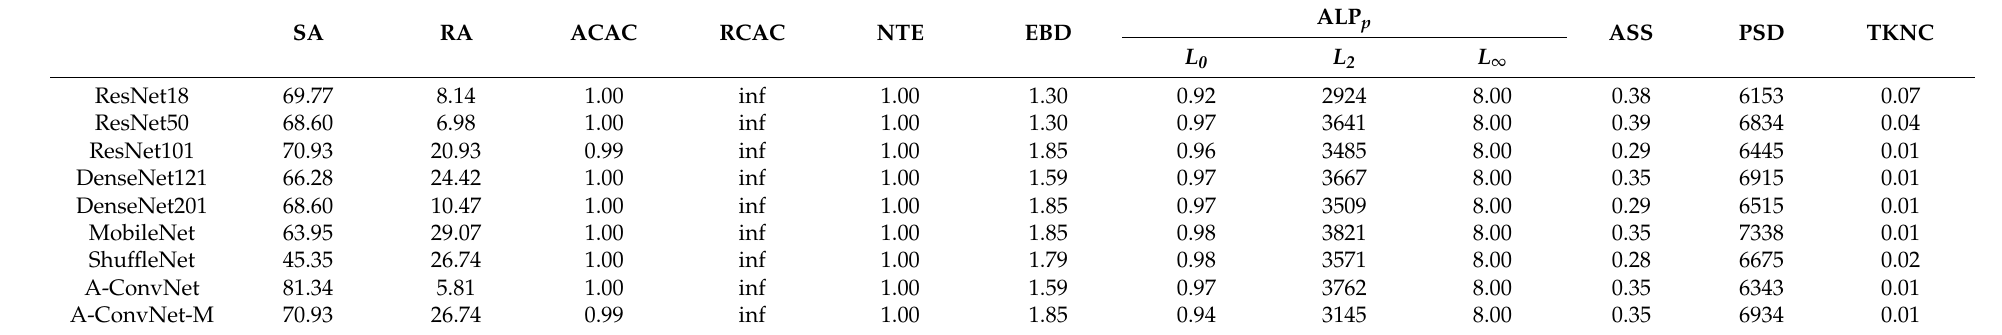
Table 8. Comprehensive evaluation of different DNN models against PGD attack (attack strength is 8/255 in L ∞ norm) in FUSAR-Ship